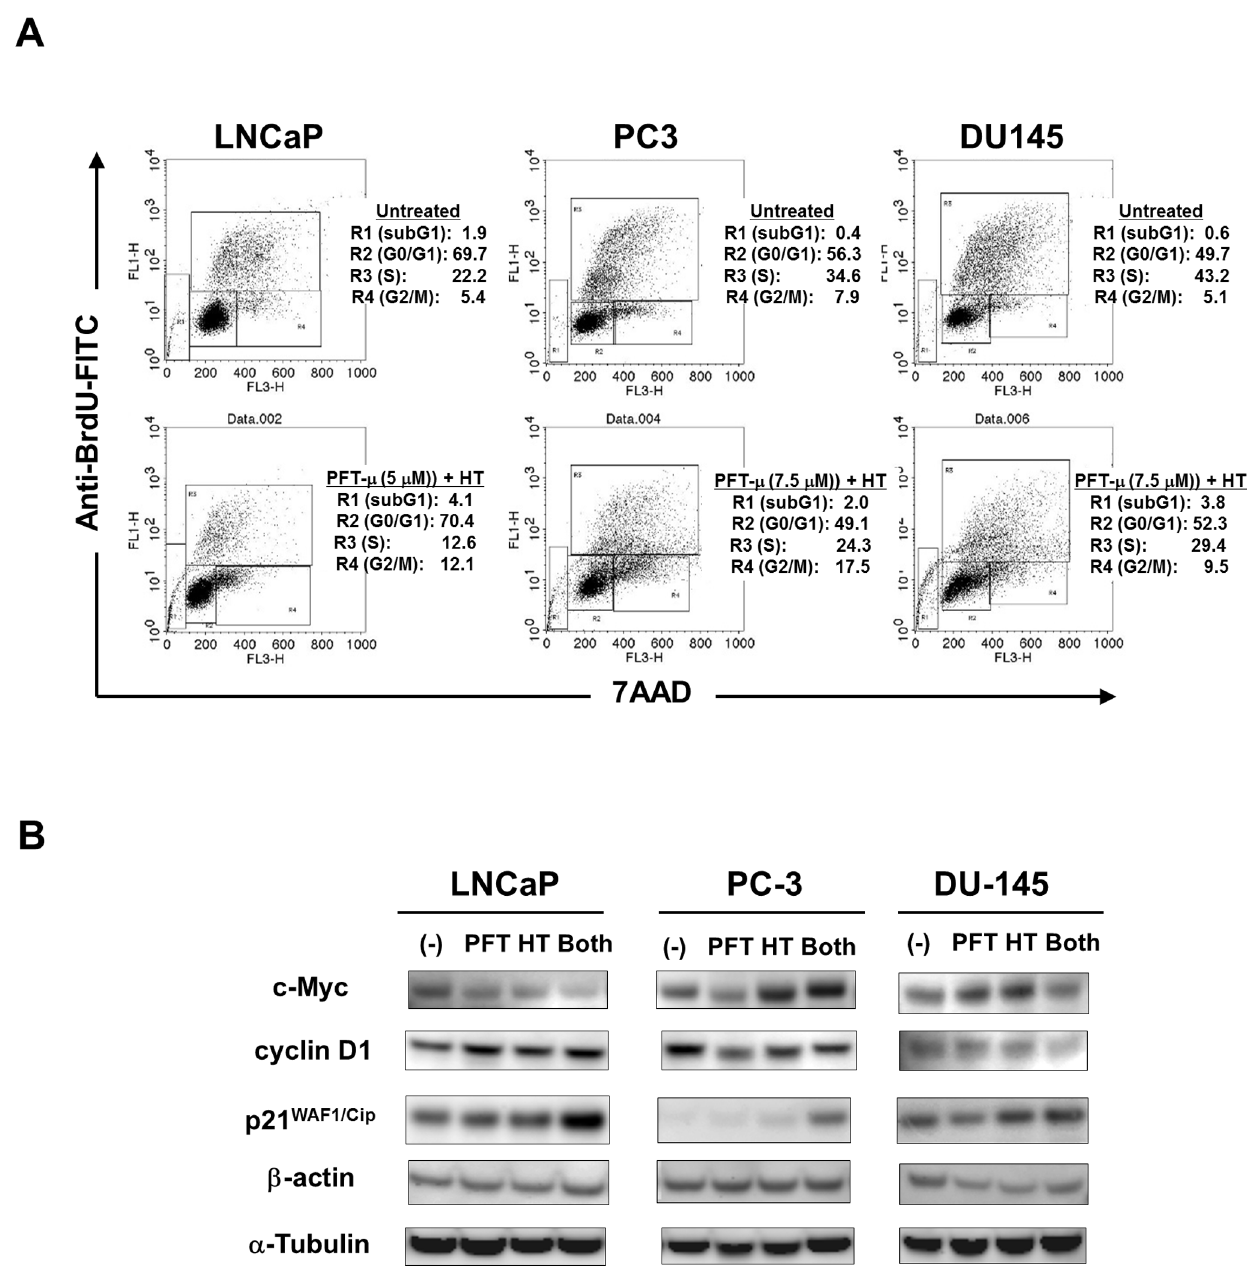
Figure 5. Combination therapy with HT and PFT- m arrested the growth of prostate cancer cells. ( A ) Three cell lines were treated with or without HT (43 u C for 2 h) and PFT- m (5 m M) for 2 days. During the last 5 h for LNCaP, 90 min for PC-3, and 3 h for DU-145, cells were cultured with BrdU (10 m M). Then, harvested cells were stained with FITC-conjugated anti-BrdU antibody and 7AAD, and flow cytometry was performed. Numbers represent the percentages of each subset. ( B ) Three cell lines were treated with either or both of HT and PFT- m (5 m M) for 2 days, and the expression levels of c-Myc, cyclin D1, and p21 WAF1/Cip protein were determined by immunoblot. b -Actin and a -tubulin were used as controls.